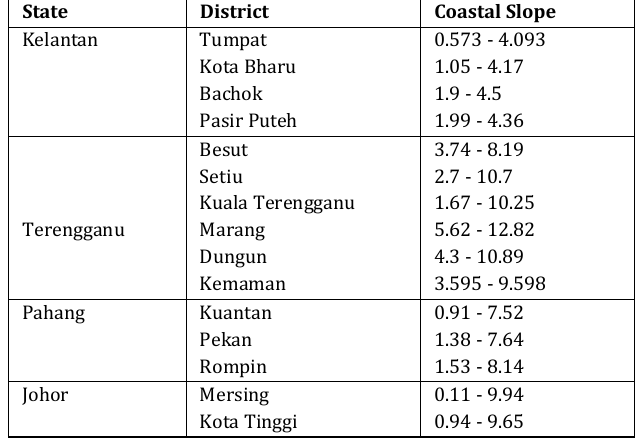
Table 3: Coastal slope for each district along the East Coast of Peninsular Malaysia [19].